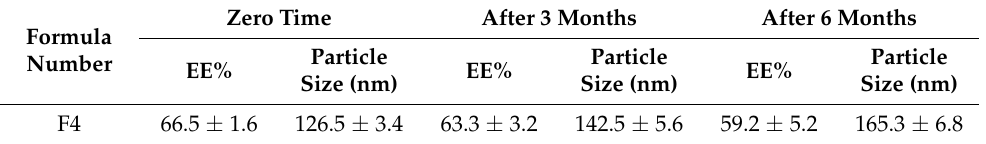
Table 2. Stability study of propolis liposomes (F4) after 3 and 6 months of storage at 25 ◦ C.